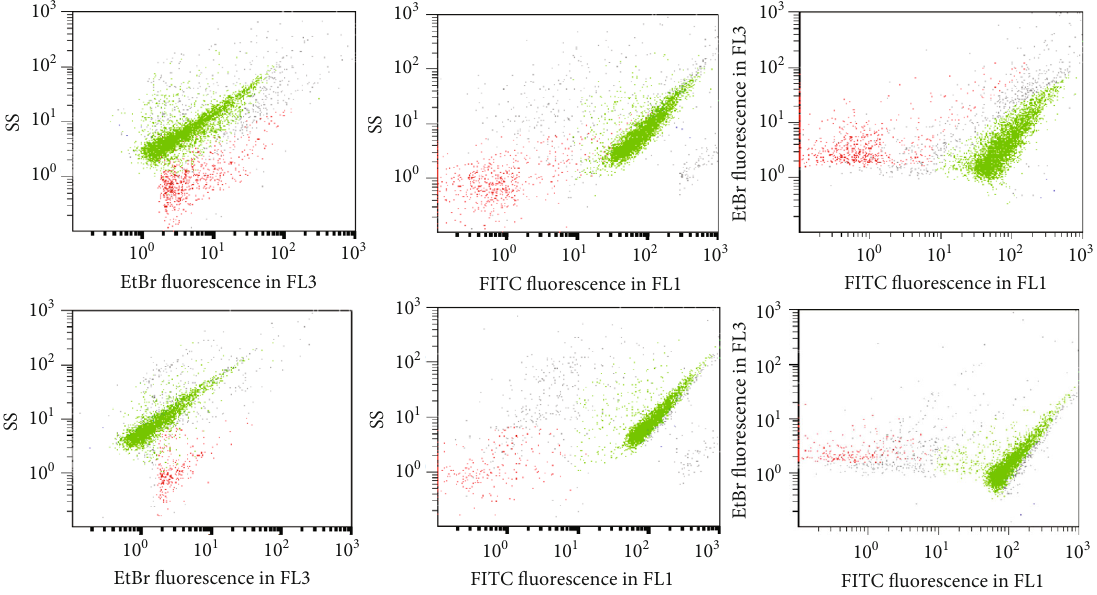
Figure 3: A serum sample of SLE with IC-eDNA and no detectable free anti-DNA antibodies. SS is the side scatter; FL3 is fl uorescence of DNA stained by EB and FL1 fl uorescence due to antibody labeling by FITC-conjugated antiglobulin. In the upper histograms, SLE serum sample incubated with ctDNA and in the lower histograms before incubation. IC-eDNA and some free DNA were already present in the serum, but after incubation with the ctDNA, the IC-DNA level did not increase signi fi cantly.